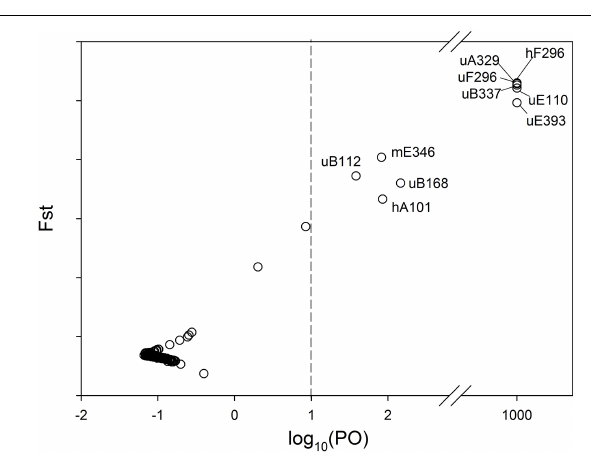
FIGURE 3 | MSAP outliers identified by Bayescan. The posterior odds (PO) for a locus to be under divergent selection are shown on a log scale on the x -axis. The vertical dash line indicates the threshold for strong evidence for selection. Outliers on the right side of the vertical line are marked with their names.